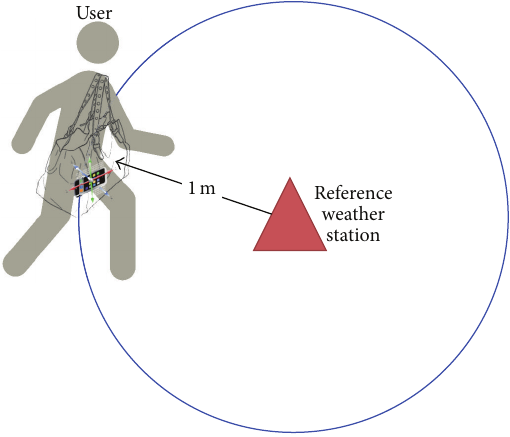
Figure 1: Setup of the stationary user